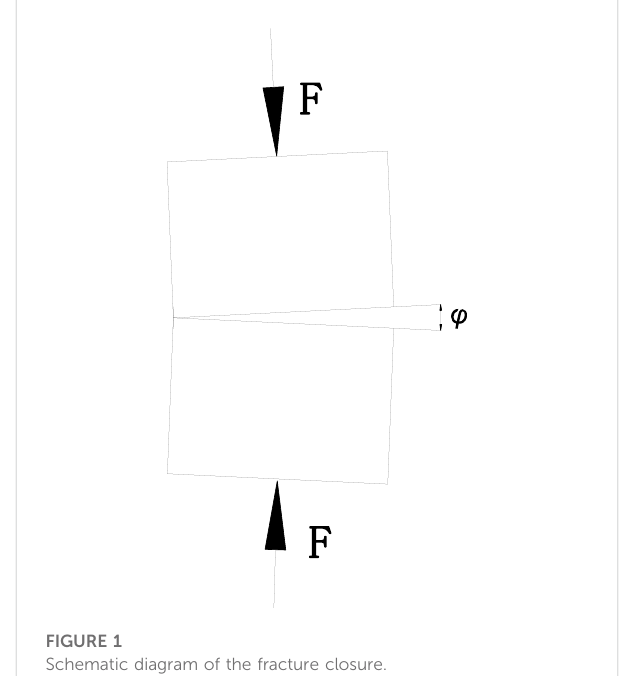
FIGURE 1 Schematic diagram of the fracture